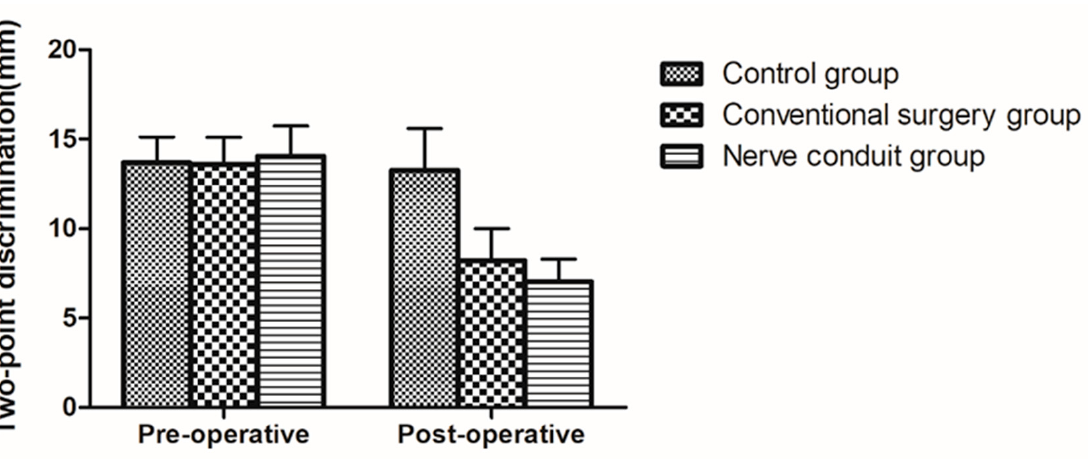
Figure 5. Diagram of 2-PD tests showing the changes in the three groups (mean ± SD).